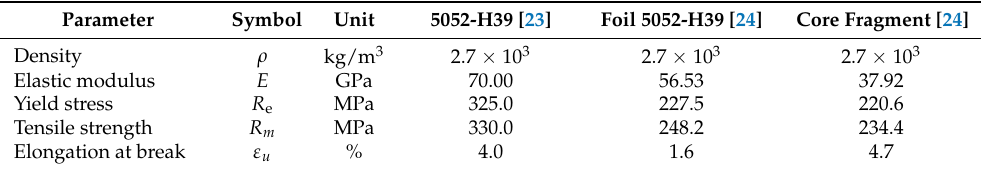
Table 3. Comparison of the mechanical properties of aluminum Al 5052-H39, a foil composed of Al 5052-H39, and a fragment of a honeycomb core composed of that